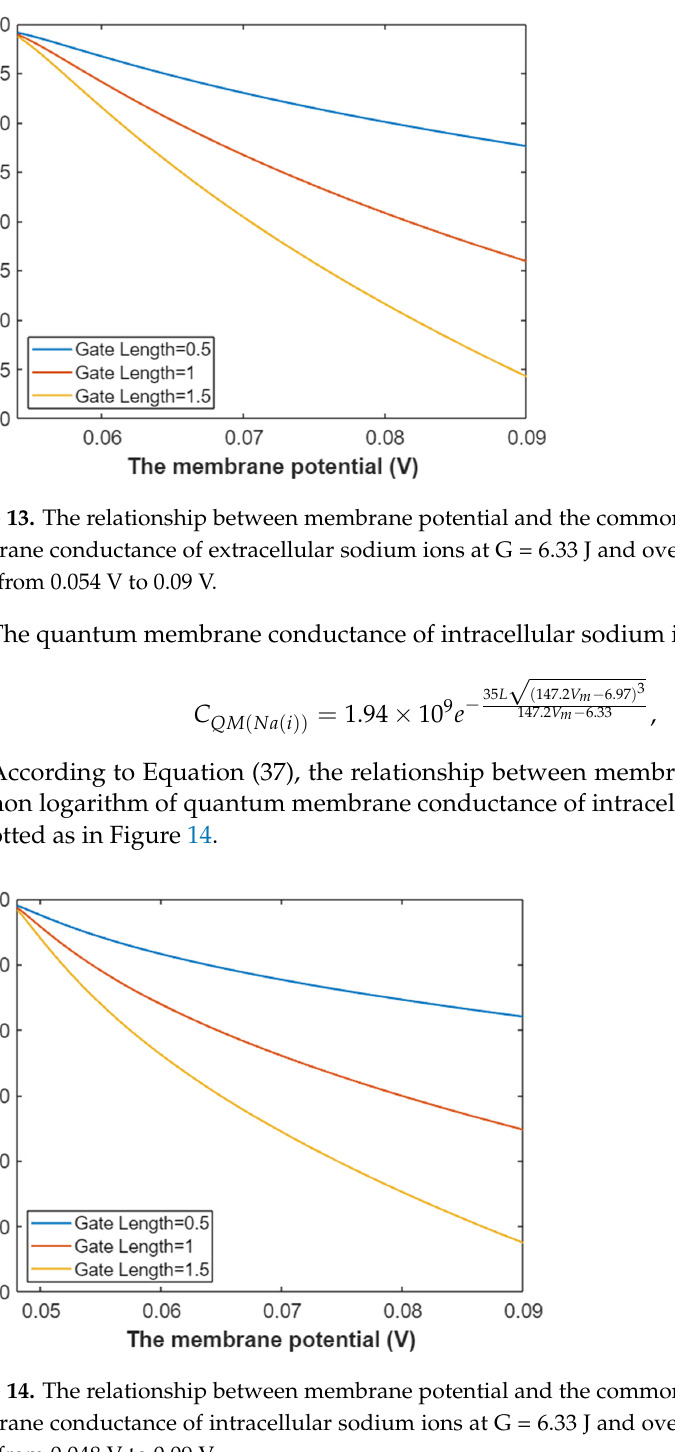
Figure 14. The relationship between membrane potential and the common logarithm of quantum membrane conductance of intracellular sodium ions at G = 6.33 J and over a membrane potential range from 0.048 V to 0.09 V. The quantum membrane conductance of extracellular sodium ions at membrane po- tential 0.087 V: